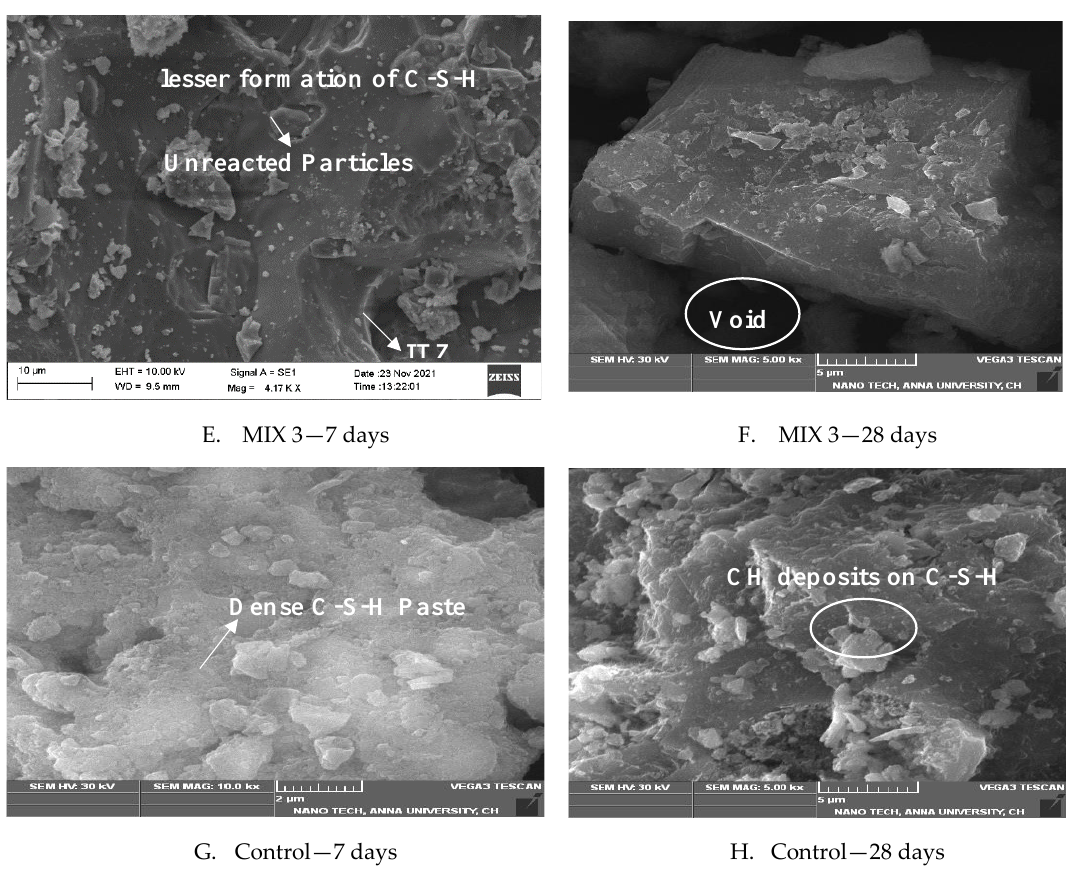
Figure 7. Secondary electron image using SEM.